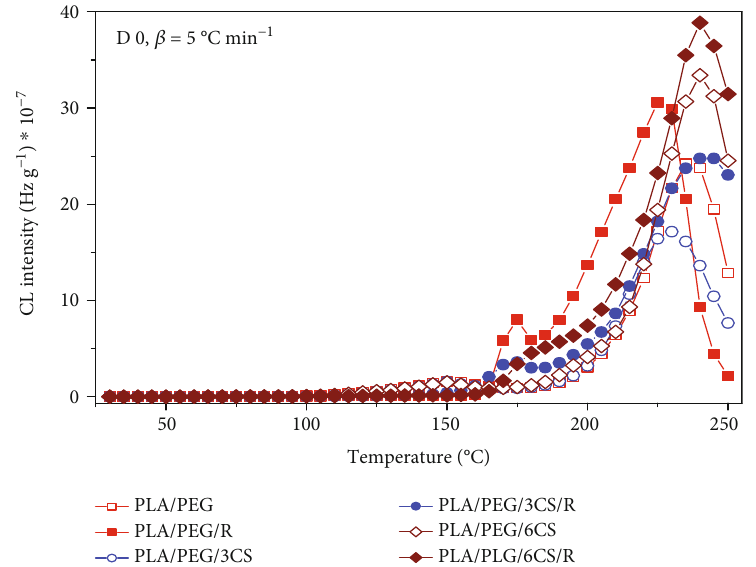
Figure 2: The dependence of the CL intensity on temperature for plasticized PLA-based system of various compositions: all samples PLA/PEG and PLA/PEG/CS; PLA/PEG/R and PLA/PEG/CS/R. Table 2: Onset oxidation temperature (OOT) and apparent activation energy (Ea) for the oxidation of the PLA/PEG and